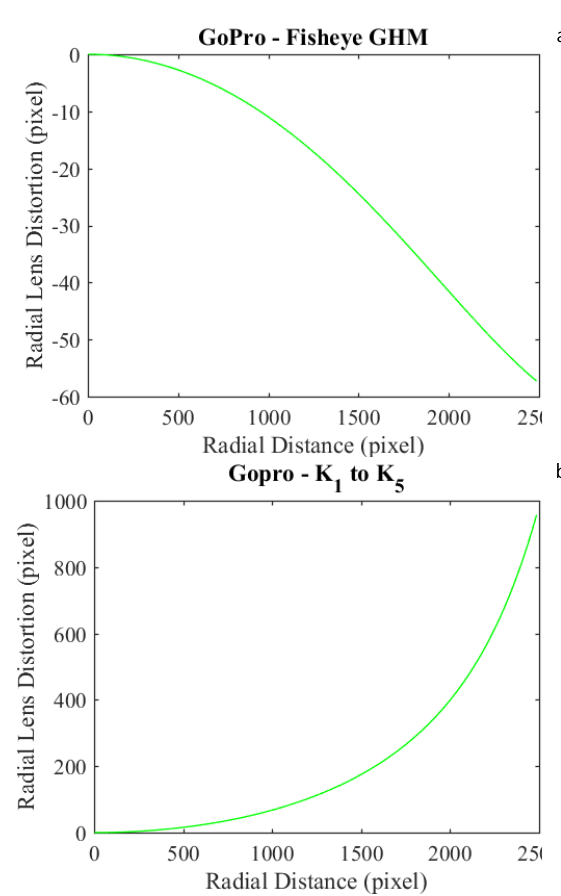
Figure 11. Radial lens distortions of GoPro using a) Fisheye GHM and b) Central Perspective